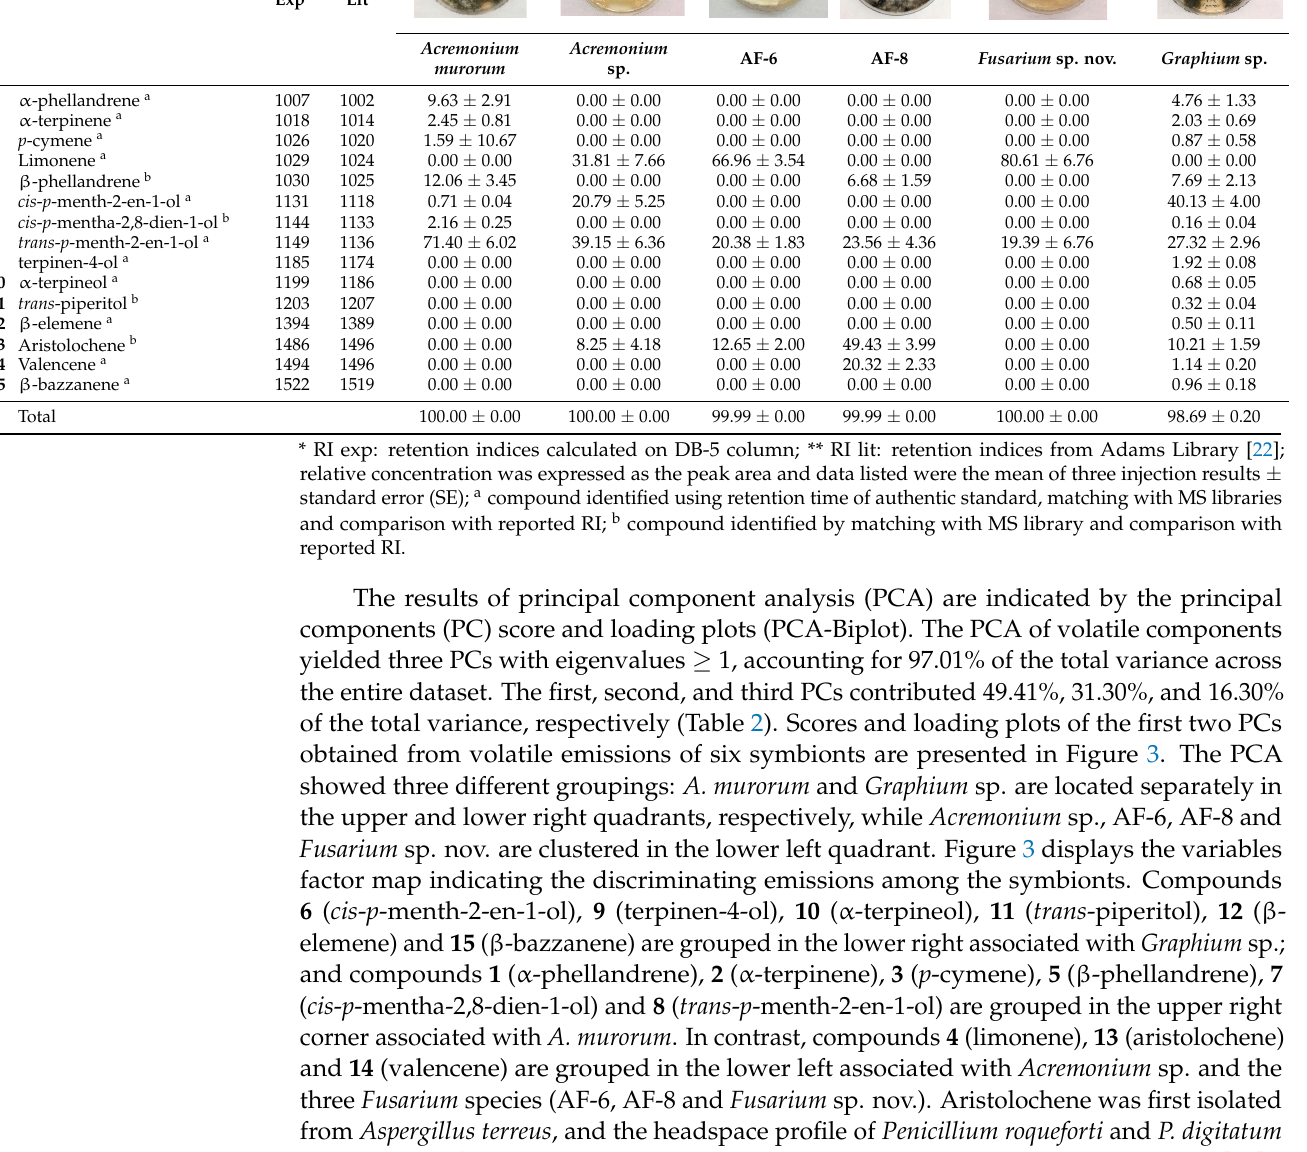
Table 1. Volatile emissions (mean ± SE) produced by fungal symbionts of Euwallacea perbrevis identified by SPME–GC–MS, expressed as the peak area percentages (%).